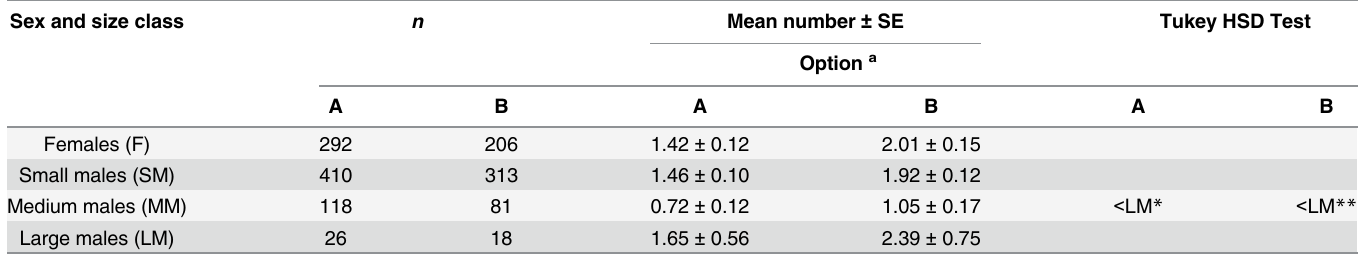
Table 4. Average number of unhealed bites on sperm whales of different size and sex classes, Donkergat, South Africa, 1963.